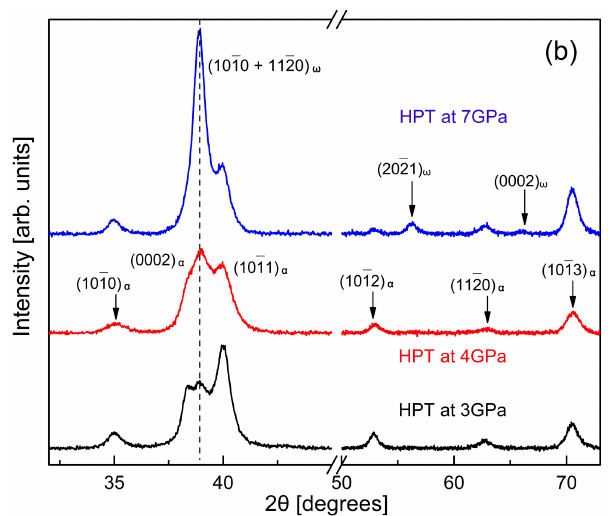
Figure 3. X-ray diffraction patterns of Ti–2 wt % Co alloy: ( a ) initial ( bottom ), compressed under 7 GPa ( middle ) and subjected to HPT at 2 GPa ( top ); and ( b ) subjected to HPT at 3 GPa ( bottom ), 4 GPa ( middle ) and 7 GPa ( top ). The patterns are vertically shifted for clarity.